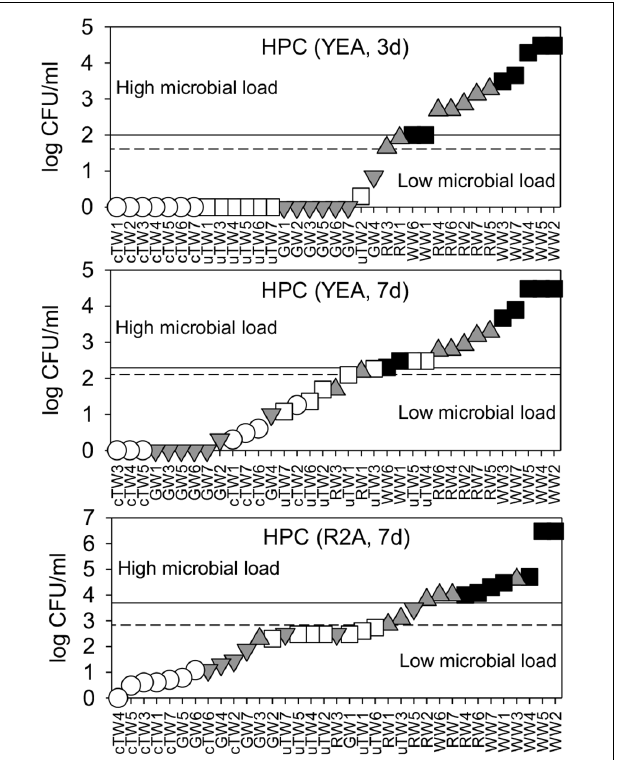
FIGURE 1 | Water microbial load as assessed by plate cultivation on Yeast Agar extract (YEA) and R2A medium, upon 3 days, and 7 days of incubation. HPC data were plotted in ascending rank order on a logarithmic scale in order to better visualize warning (dashed lines) and alarm (solid lines) thresholds, which discriminate waters with low and high microbial load. Samples included chlorinated Tap Waters (cTW1-7), unchlorinated Tap Waters